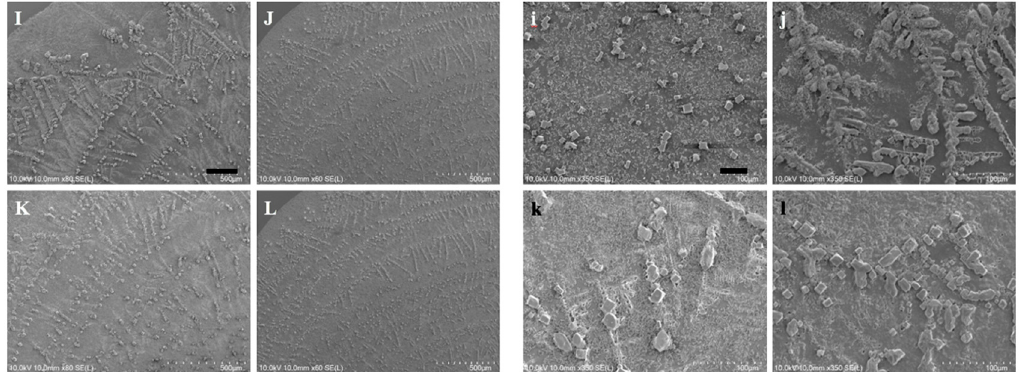
Figure 7. SEM images acquired at the edges of ( a – d ) pure and ( e – h ) CsWO 3 NP-doped LAFs treated with an array of designated temperature; the scale bar shown in ( a ) is 80 μ m, applicable to all images in this figure.